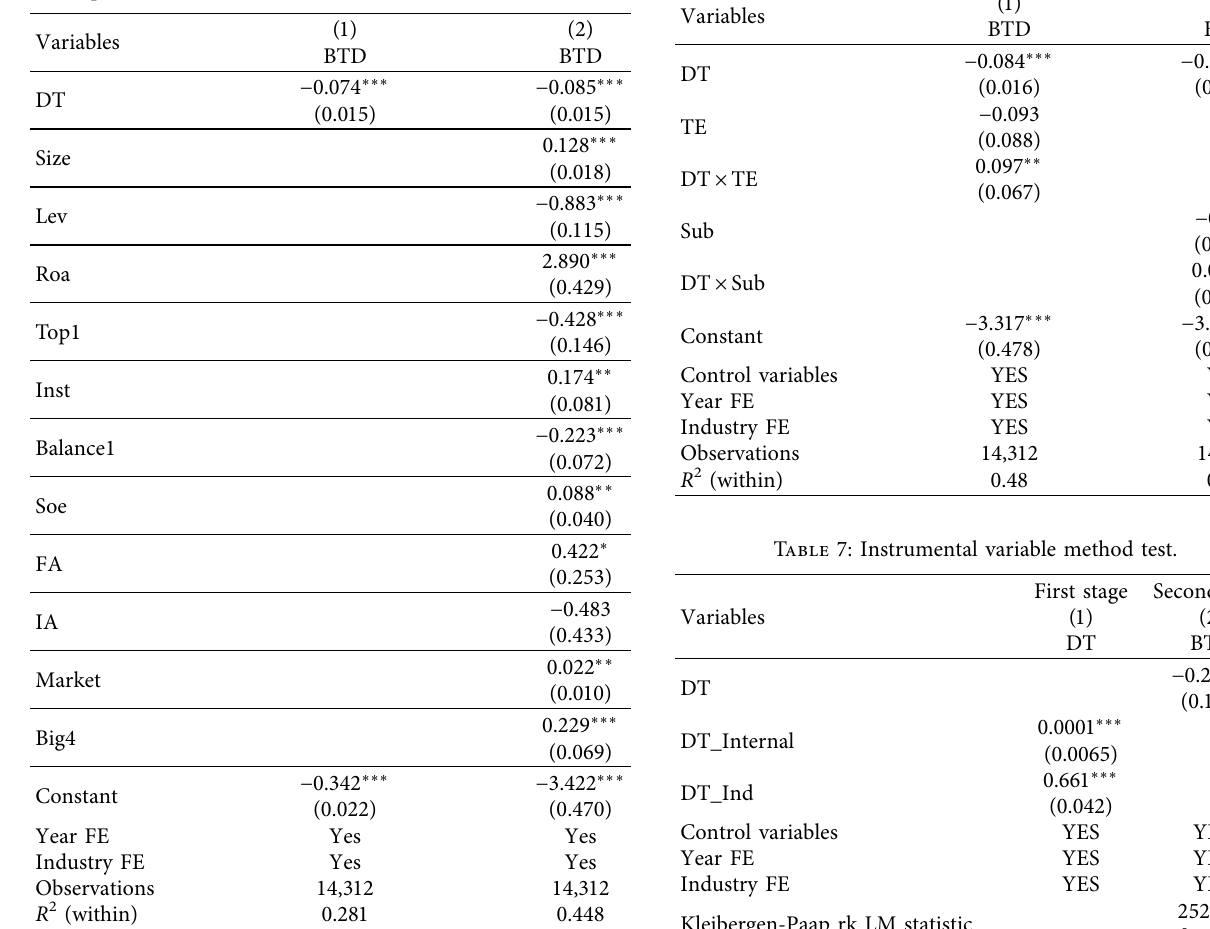
Table 4: Regression results of the impact of digital transformation on corporate tax avoidance.